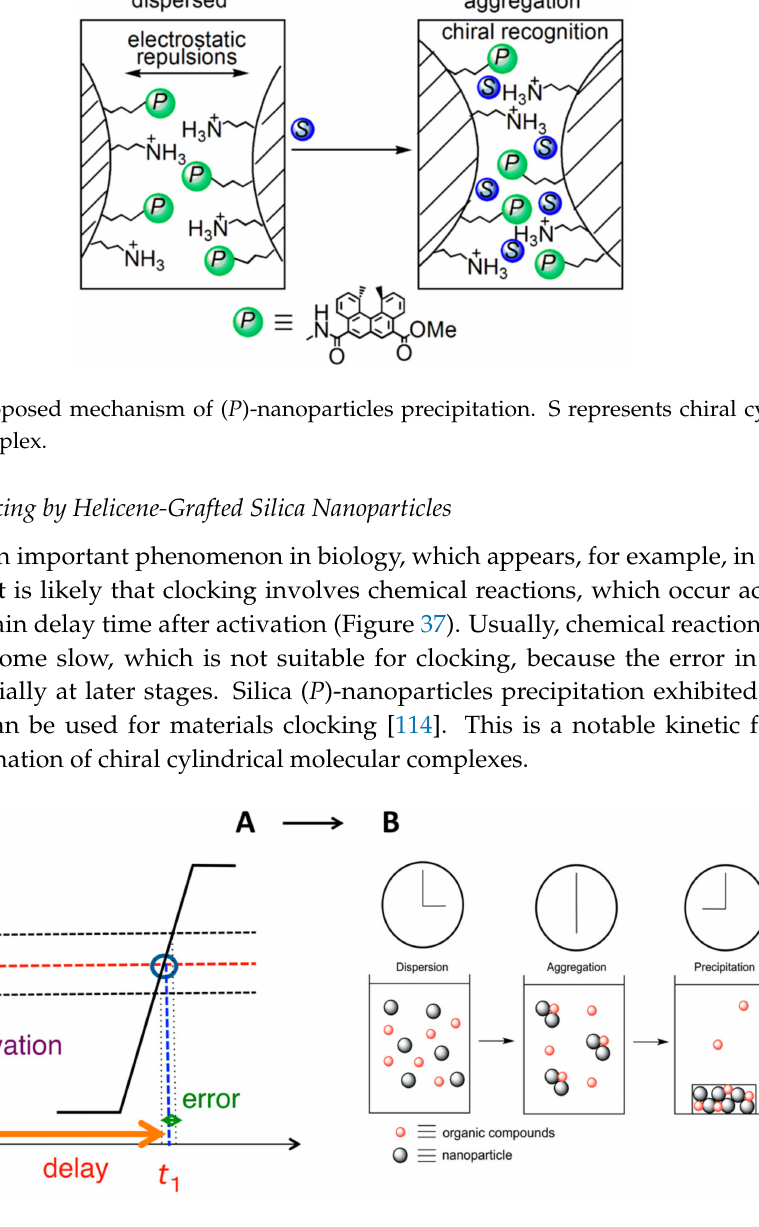
Figure 37. Materials clocking system using precipitation of ( P )-nanoparticles in the presence of A -to- B